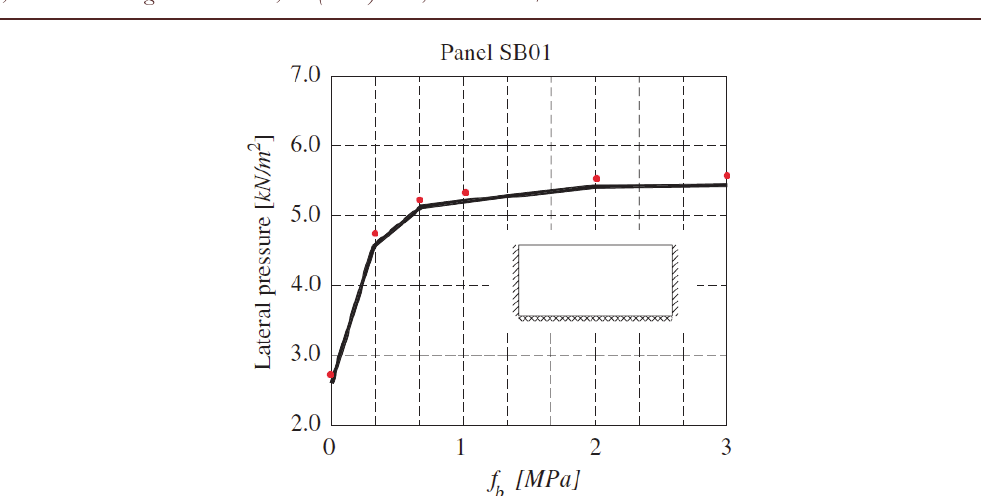
Figure 9: Dependence of the collapse load multiplier of reinforced Panel SB01 on the FRP-masonry bond strength f b . Red dots: values computed by means of the proposed GA-NURBS approach; Black line: values computed in [25].